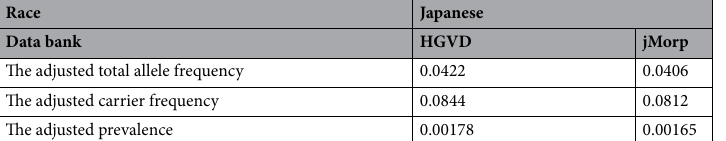
Table 2. Adjusted total allele frequencies of SLC12A3 variants according to ACMG/AMP 2015 guidelines and adjusted carrier frequency and prevalence of GS in a Japanese